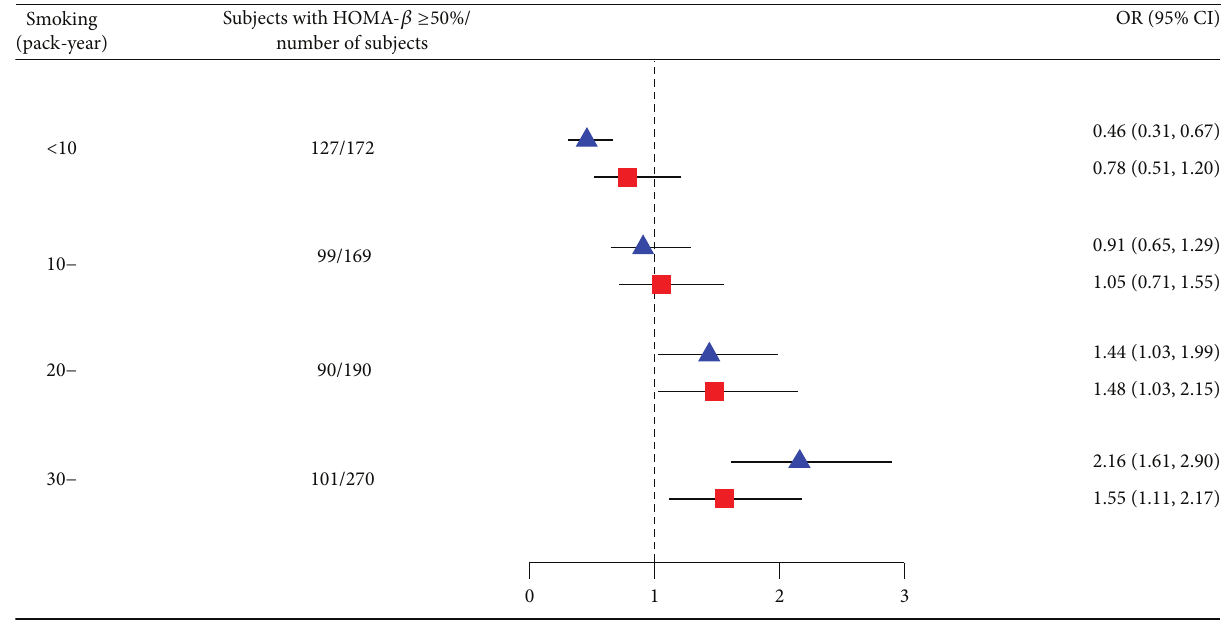
Figure 1: The associations between smoking intensity and 𝛽 -cell function. The triangles and squares represent crude odds ratios (ORs) and ORs after adjustment for age, education level, drinking status, body mass index, waist circumference, level of physical activity, hypertension, and dyslipidemia. The horizontal lines represent 95% confidence